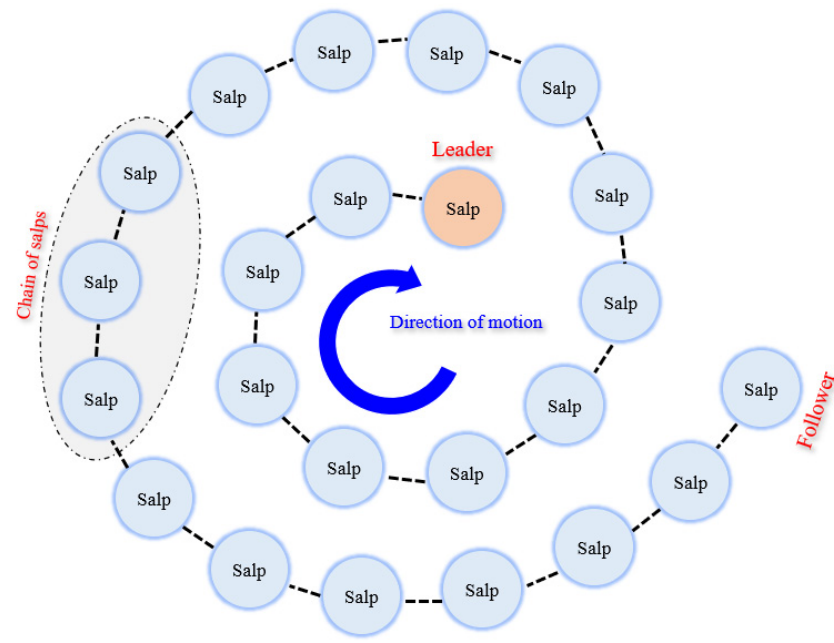
Figure 1. The natural behavior of salp swam in the deep ocean.